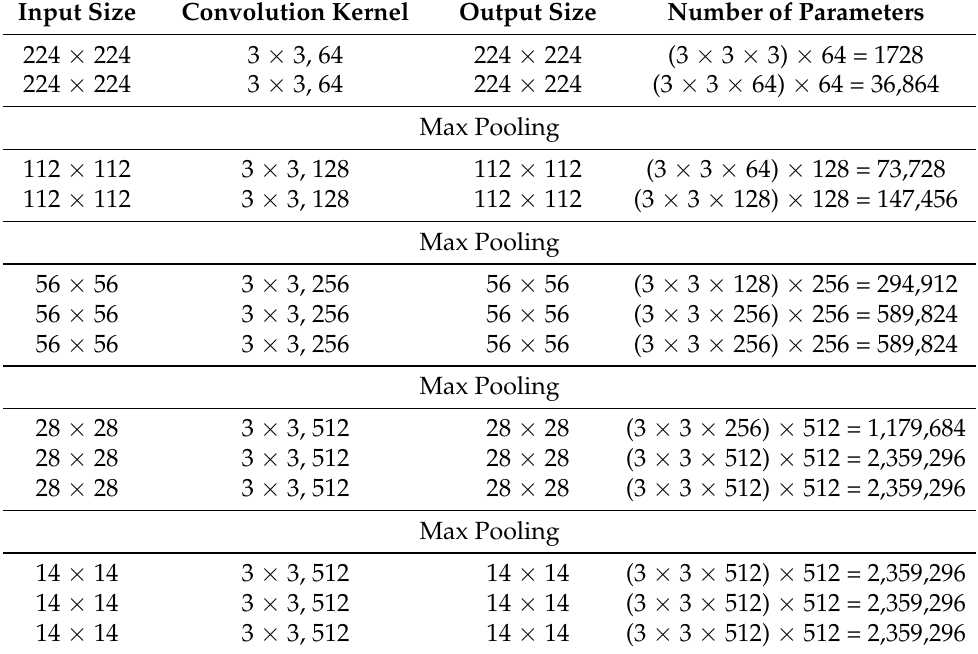
Table 1. The architecture of backbone